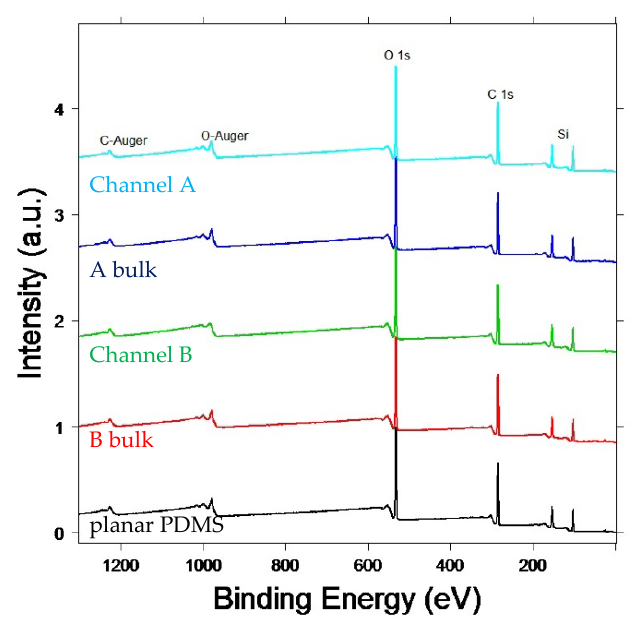
Figure 4. X-ray photoelectron spectroscopy (XPS) survey spectra taken at 0° take-off angle. Spectra were taken inside microdevices channels (curves named Channel A and Channel B) and outside channels, i.e., on freshly cut microdevice surfaces (A bulk and B bulk). A planar PDMS surface was also measured for comparison (planar PDMS). Table 1. XPS relative quantification (%) of O, C, and Si detected with a 0° take- off angle on inner (Channel A or B) and outer surfaces (Chip A or B bulk) of microdevices channels and on PDMS planar surfaces. The standard error does not exceed the 1%–2% of the reported value.